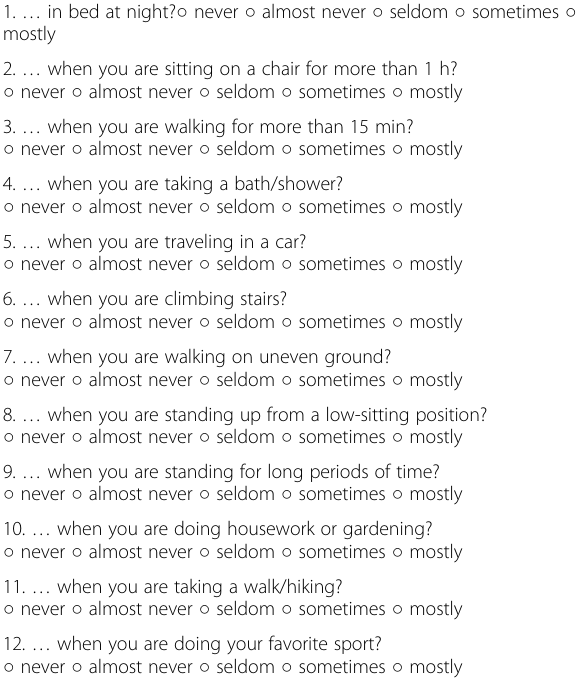
Table 1 The English version of the forgotten joint score has 12 questions on the awareness of the artificial joint. The patient ticks one answer from each